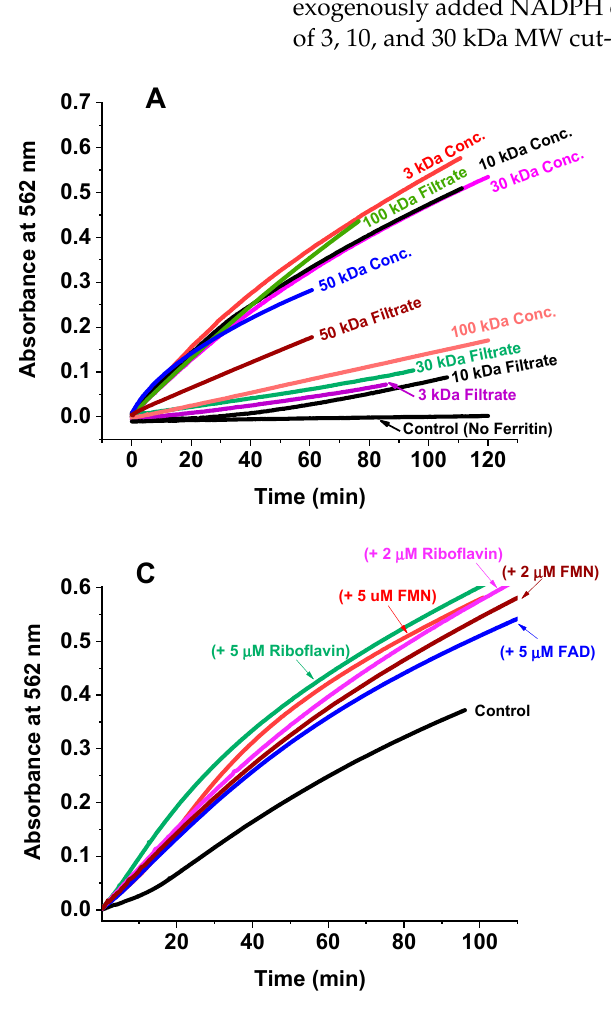
Figure 2. Iron reduction and release kinetics monitored by UV-Vis using cell lysate filtrate or retentate solutions separated using different MW membrane cut-offs (3, 10, 30, 50, or 100 kDa). ( A ) The control-subtracted iron release kinetics of the partitioned cell lysate solutions.( B ) In the absence of exogenously added NADPH or ferritin, the iron release kinetics. ( C ) The kinetics of iron release were followed in the presence of 2–5 µM FMN, FAD, or riboflavin using freshly prepared whole cell lysate solutions. Conditions: 555 µL of the retentates or filtrates, 1.5 mM NADPH, 0.8 µM homopolymer H-ferritin or heteropolymer ferritins (H19:L5, H22:L2) loaded with 500Fe(III)/shell, 3 mM ferrozine, 2–5 uM FMN, FAD or riboflavin, 20 mM MOPS, pH 7.4. The displayed kinetics are averages of at least 2 different trials. The control kinetic experiment using cell lysate in the absence of ferritin is similar to that of buffer with ferritin.